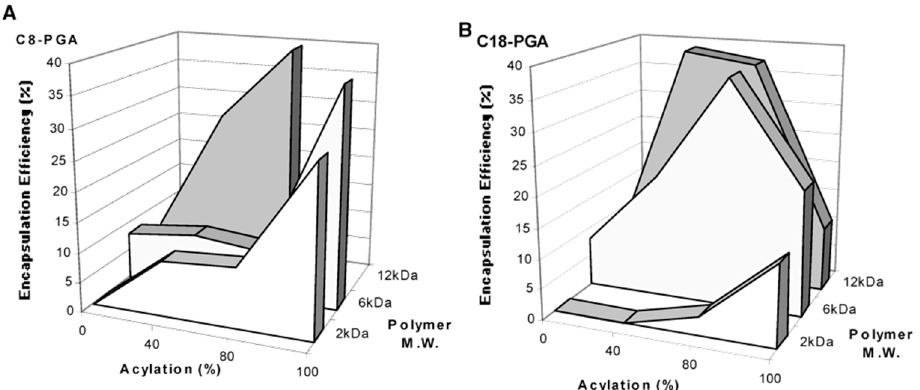
Figure 3. E ff ect of acylation percentage on encapsulation e ffi ciency [14]. ( A ) is a C 8 pendant acyl chain and ( B ) is a C 18 pendant acyl chain. The degree of acylation has a clear e ff ect on the encapsulation e ffi ciency of dexamethasone phosphate, as does the polymer molecular weight. Copyright 2005 American Chemical Society.